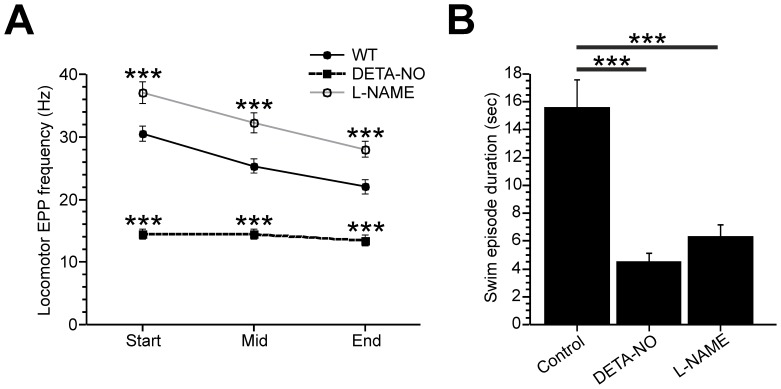
Developmental effects of NO on the frequency and duration on the neuromuscular drive for locomotion.
A. Line graph of mean (± SEM) locomotor-related end plate potential (EPP) frequency at the beginning, middle and end of evoked fictive swim episodes in control fish and fish exposed to DETA-NO or L-NAME during development. B. Bar chart showing mean duration of fictive motor episodes in control, DETA-NO and L-NAME treated fish. *** p<0.001.